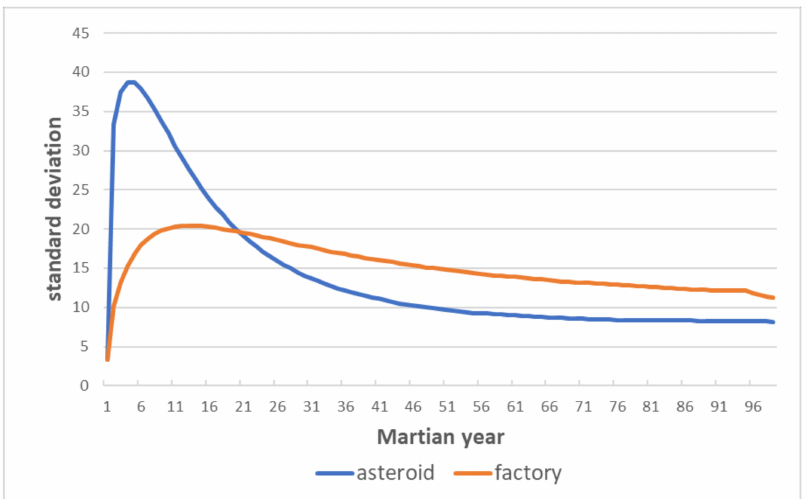
Figure 12. Standard deviation of the temperature rise on Mars over 100 simulation years after the initial